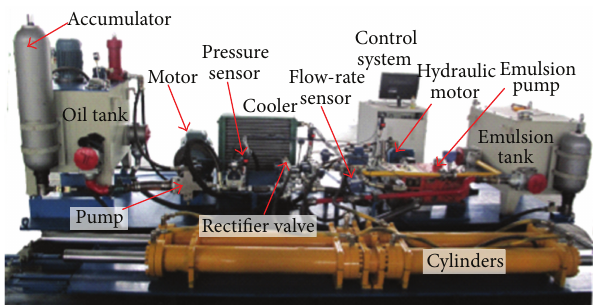
Figure 14: Test bench.